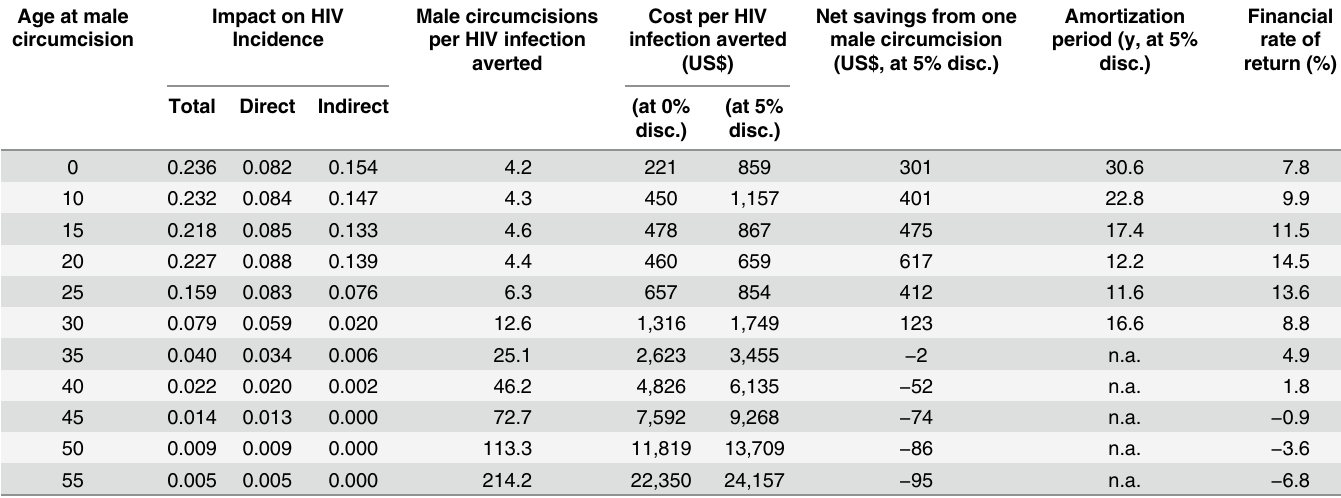
Table 1. Summary of results (based on one male circumcision performed in South Africa in 2013).